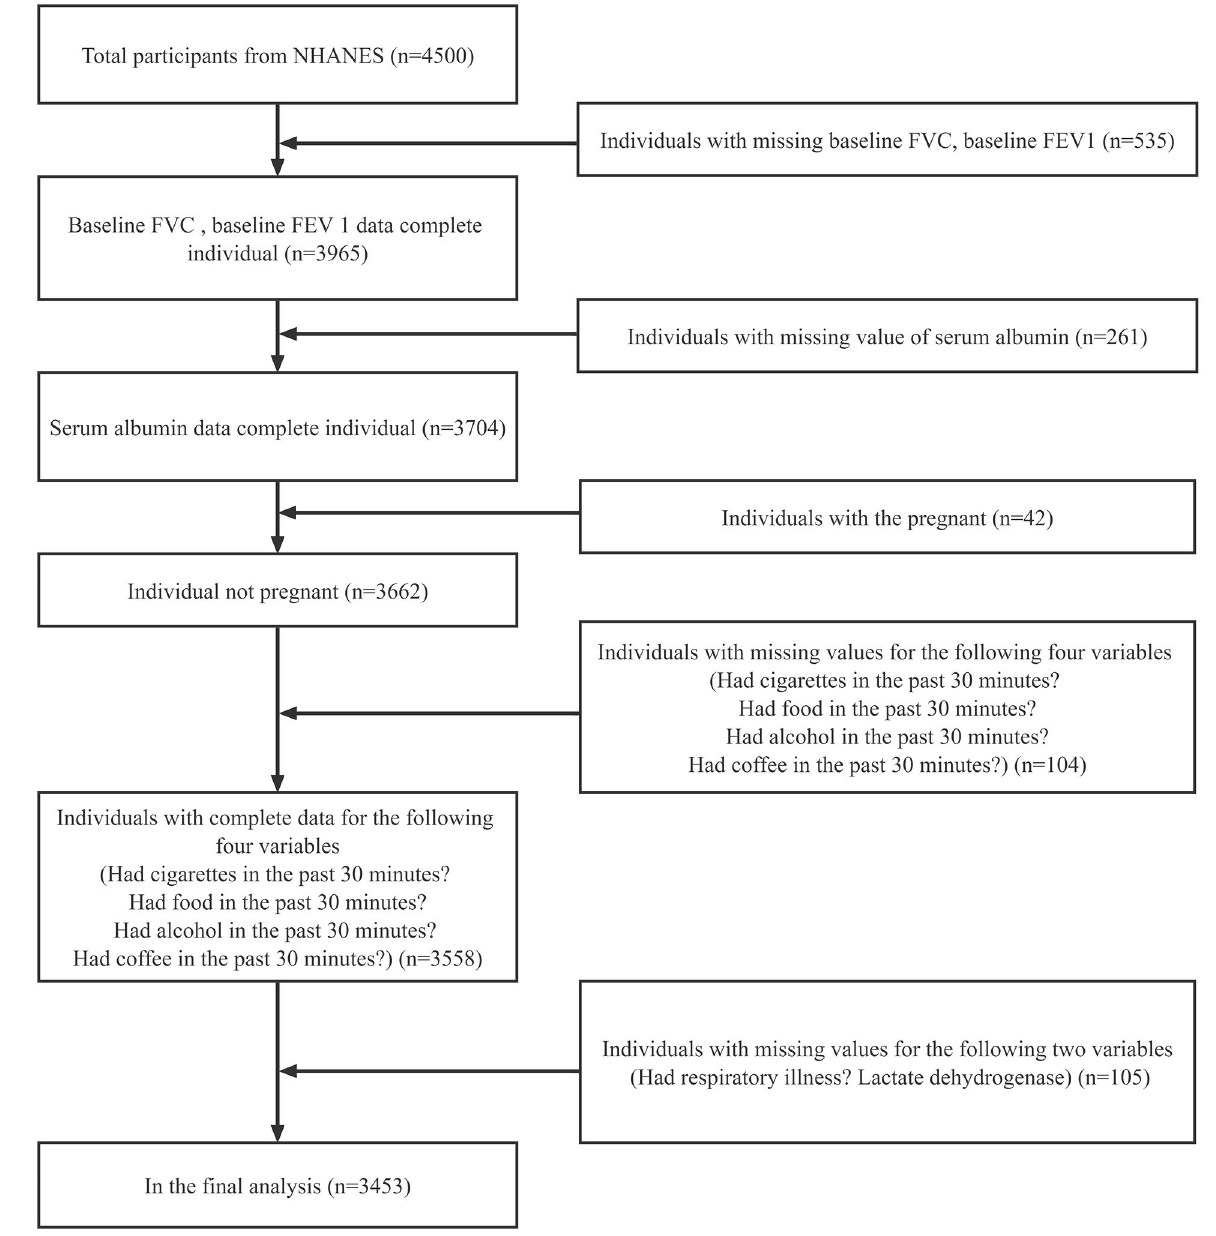
Fig 1. Flowchart of the screening process for selecting eligible participants from NHANES 2011–2012.